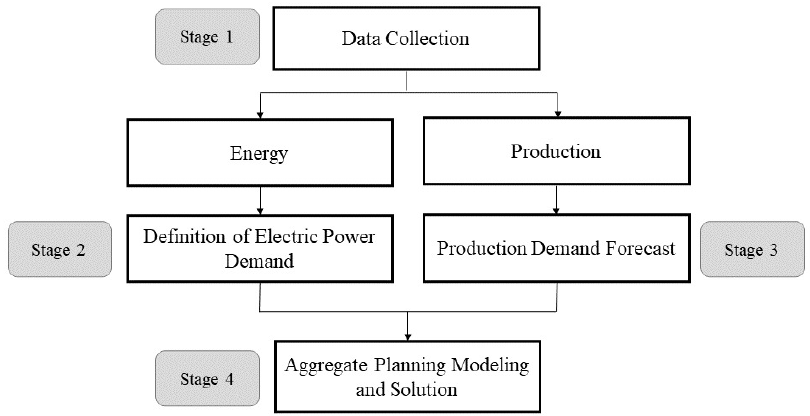
Figure 1. Stages of the proposed model.